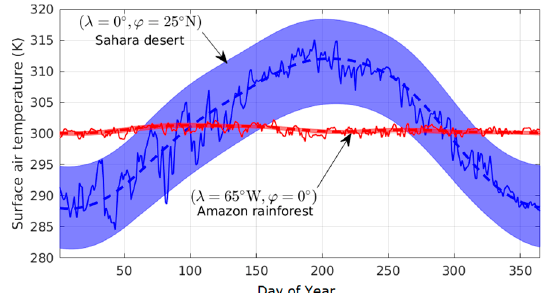
Figure 2. Maximum spatial variability for each surface air temperature periodicity, which was calculated using a window of 4 × 4 grid points, approximately a 1° × 1° horizontal grid: ( a ) maximum spatial variability for the annual amplitude (K), ( b ) maximum spatial variability for the semi-annual amplitude (K), and ( c ) maximum spatial variability for the quarterly amplitude (K).